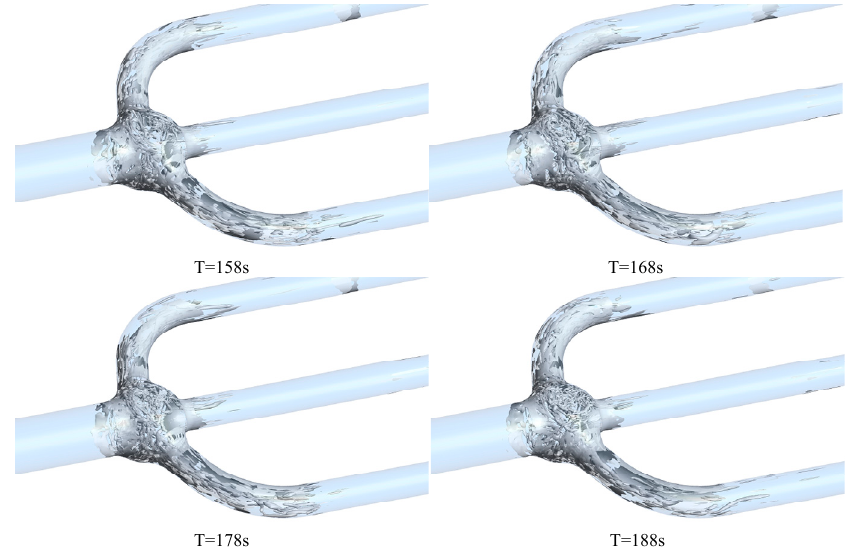
Figure 8. Vortex structures around the trifurcation at different times (original model).